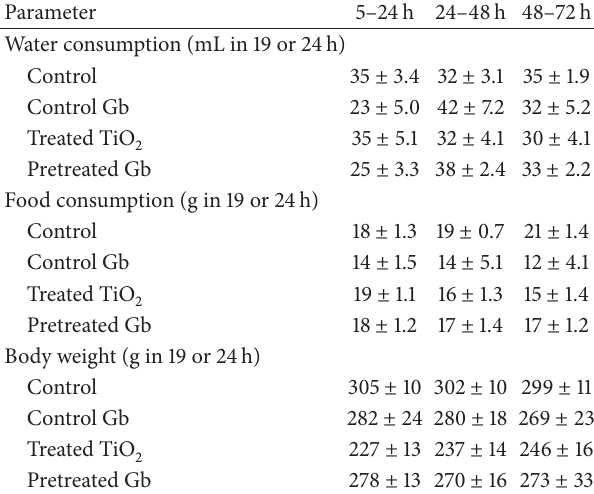
278 ± 13 270 ± 16 273 ± 33